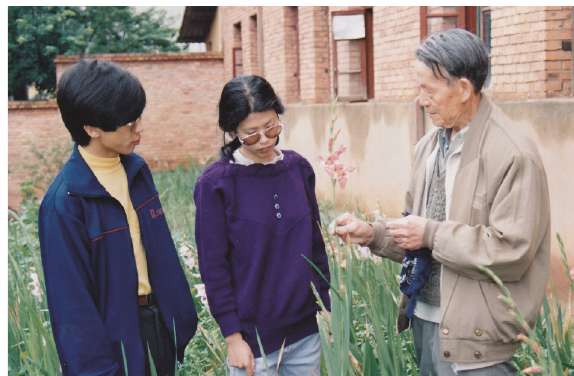
Figure 5. Prof. Duan was mentoring his